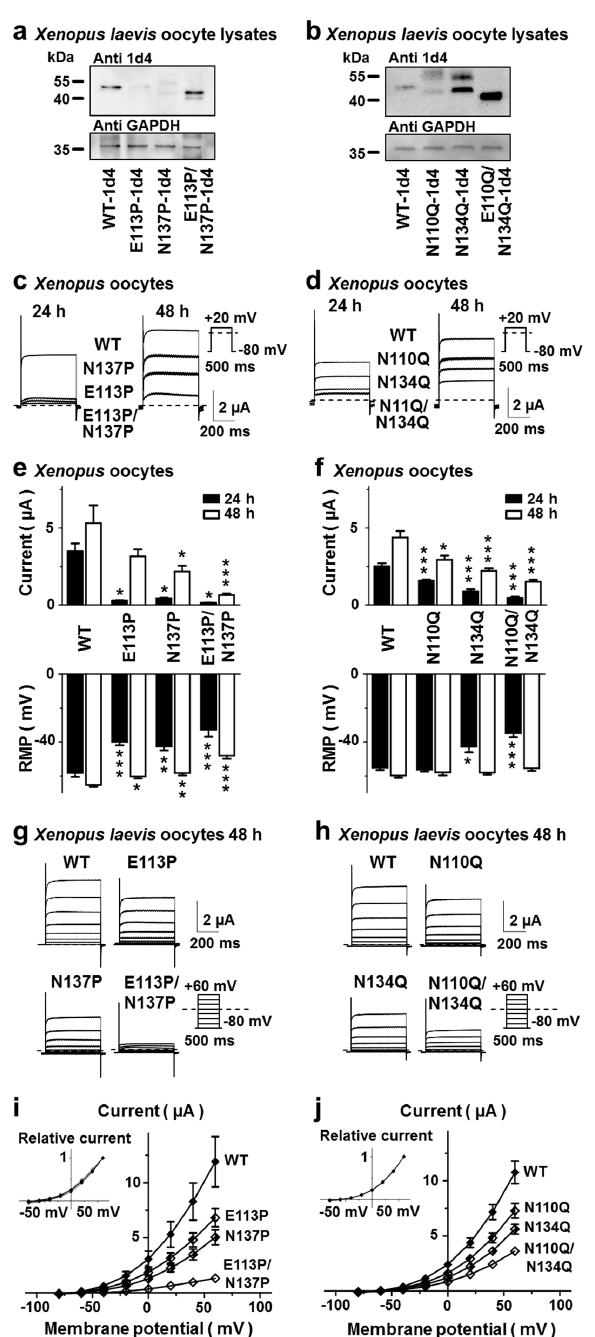
Figure 3. Molecular biological disruption of hTREK-1 N -glycosylation. ( a ) N -glycosylation can be disrupted either by introducing a proline residue in position +3 relative to the N -glycosylation acceptor residue ( a , c , e , g , i ) or by substituting the carbohydrate acceptor asparagine to glutamine ( b , d , f , h , j ). ( a , b ) Protein lysates of Xenopus laevis oocytes injected with RNA of the indicated hTREK-1-1d4 mutant constructs lacking the first, the second or both the first and second N -glycosylation motifs were subjected to immunoblotting. Changes in carbohydrate modifications are displayed as altered electrophoretic mobility. Please note that the E113P substitution resulted in incomplete disruption of N -glycosylation at N110. The immunosignals of glyceraldehyde 3-phosphate dehydrogenase (GAPDH) are given as loading controls. ( c , d ) Representative current traces recorded from Xenopus laevis oocytes expressing the indicated hTREK-1 variants after 24 h (left) or 48 h (right). The currents were evoked by the